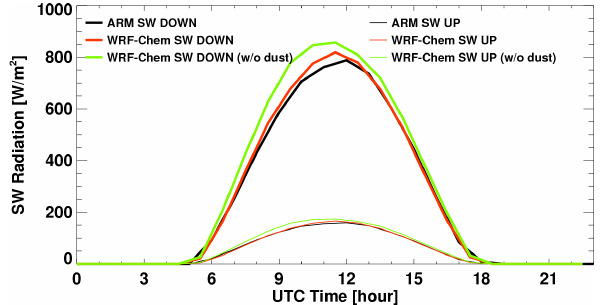
Table 1. WRF-Chem simulated 24-h all-sky radiative forcing of